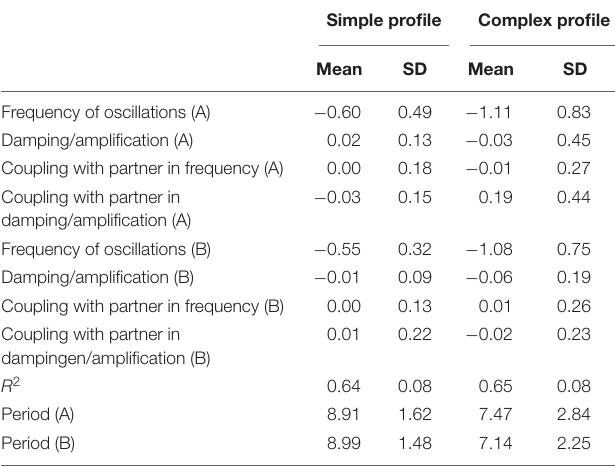
TABLE 3 | Summary of CO model parameters for the simple profile (109 context-couple combinations) and the complex profile (24 context-couple